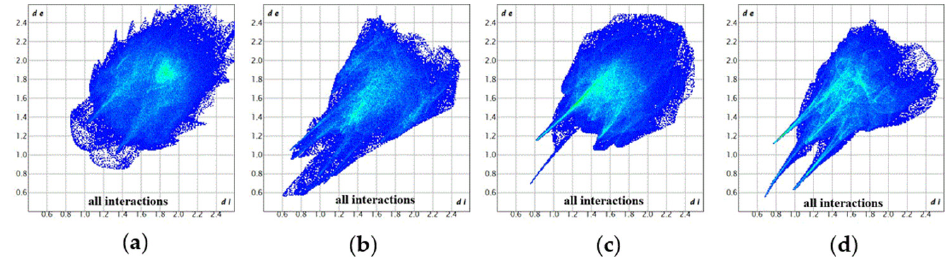
Figure 9. 2D fingerprint plots with di and d e ranging from 1.0 to 2.4 Å for 1 ( a ), 2 ( b ), 3 ( c ) and 7 ( d ).